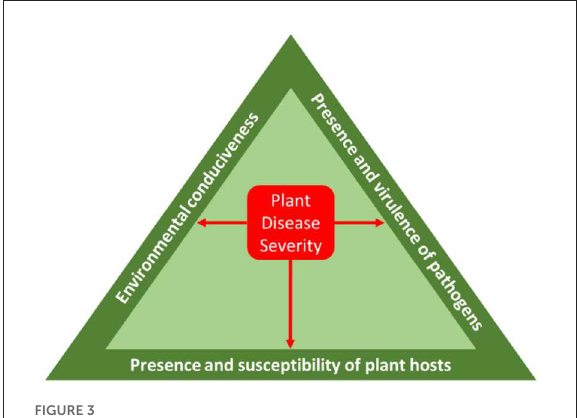
FIGURE3 The disease triangle. Redrawn based on Fones et al.